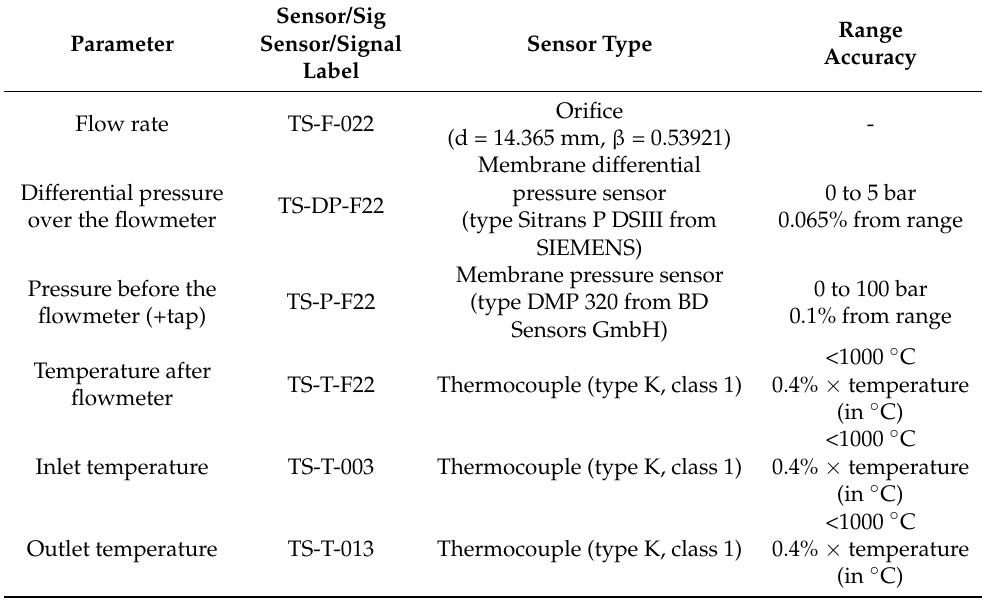
Table 3. List of helium parameters monitored for the FG